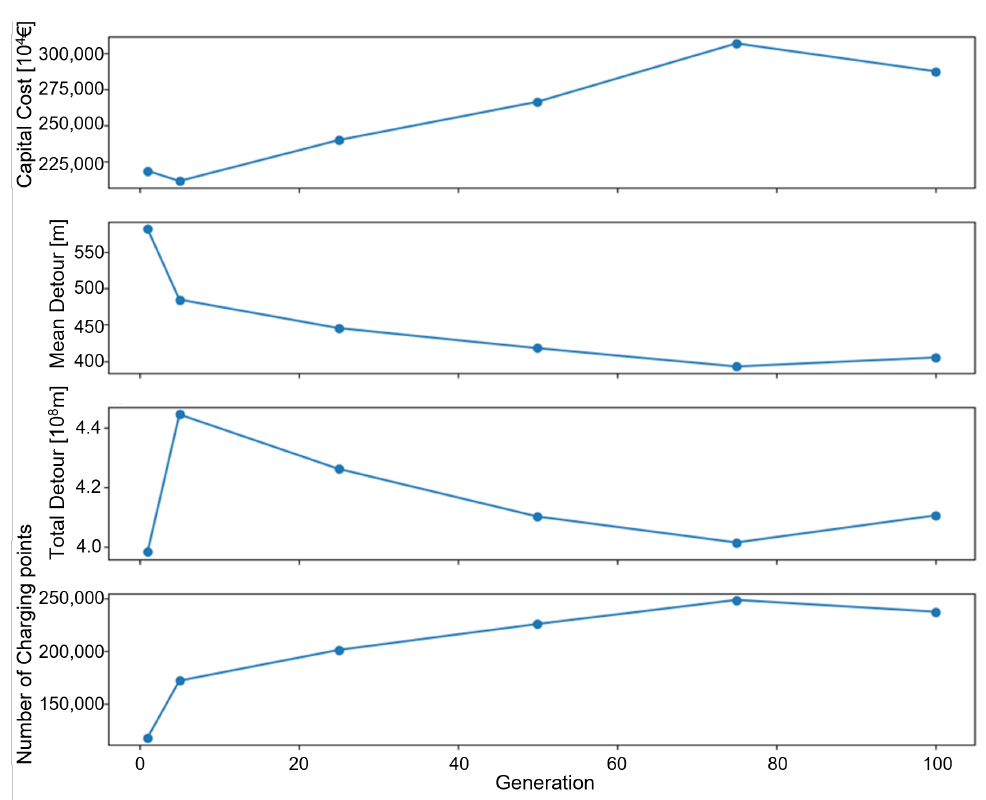
Figure 7. Development of key values of solutions across generations.